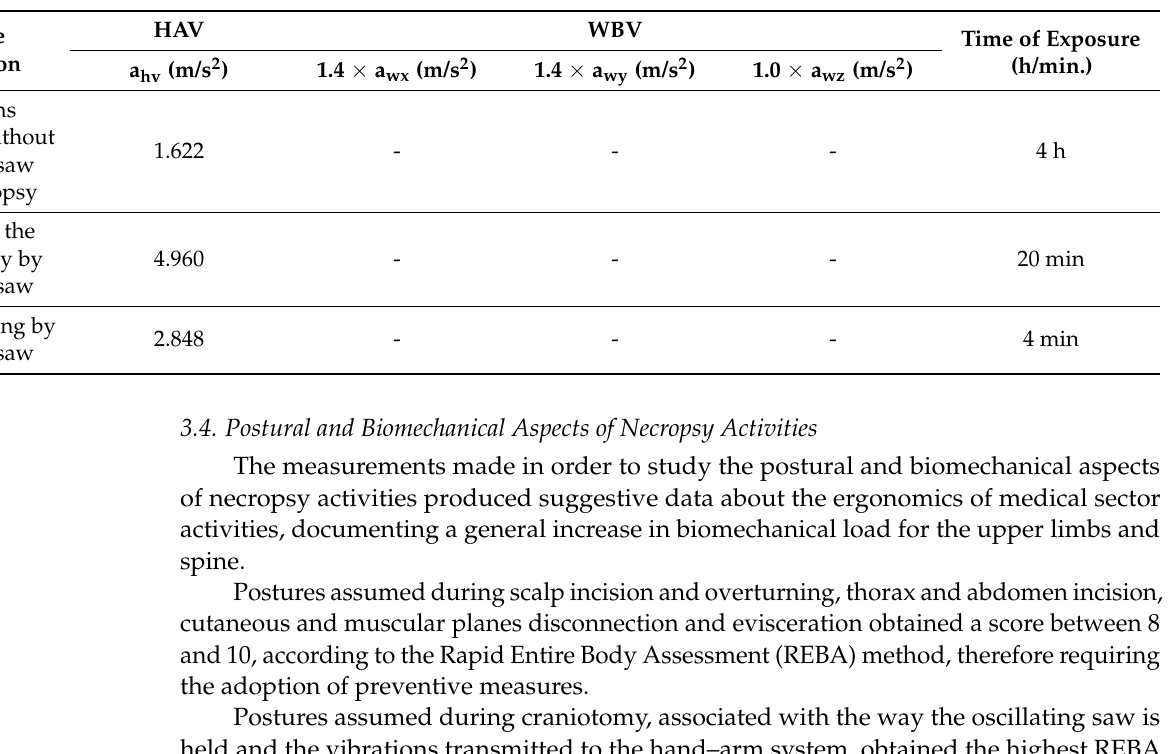
Table 4. Daily vibration exposure levels assessment A